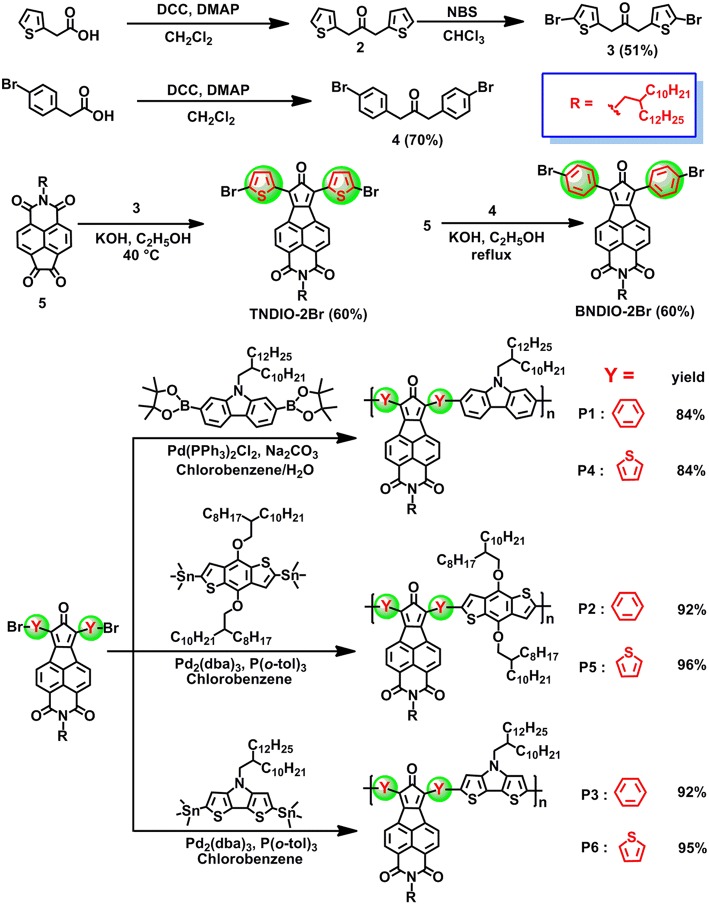
Synthetic route for the CPONI-based monomers and their copolymers.